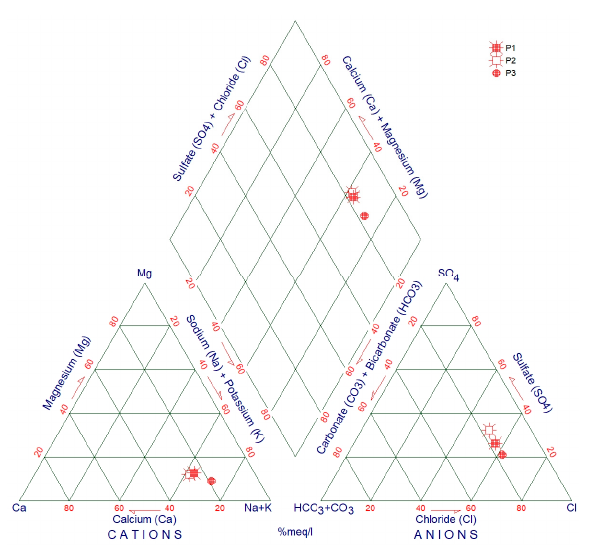
Figure 15. Piper diagram of the water samples collected in the Regoufe mine (February 2022).